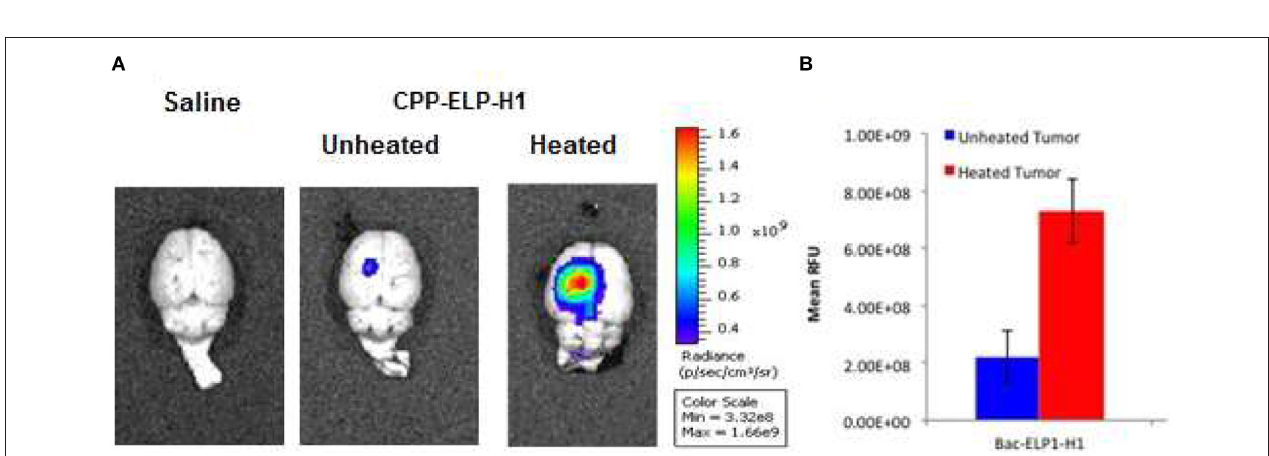
FIGURE 4 | Enhancement of CPP-ELP1-H1 Tumor Uptake by Thermal Targeting. Following IV administration of Alexa750-labeled CPP-ELP1-H1 with or without hyperthermia, construct levels in tumors and organs were determined by ex vivo whole organ fluorescence imaging. (A) Representative brain images from each treatment group. (B) Quantitation of tumor fluorescence from each group. Bars, s.e.m. *, Fluorescence levels differ statistically ( p , 0.01, one way ANOVA with post-hoc Bonferroni; n = 4 rats/group).